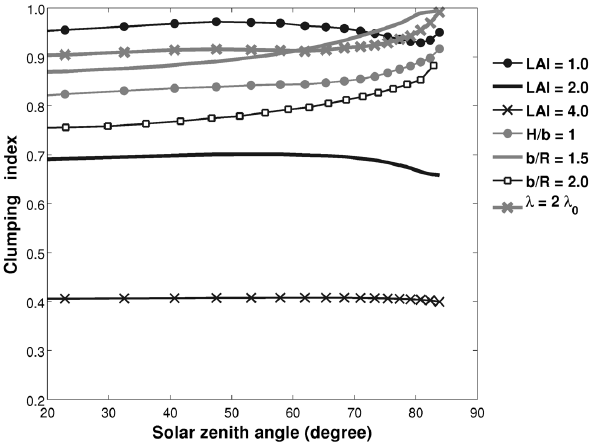
Figure 14. Derived clumping index as a function of solar zenith angle for varied canopy parameters. Tree parameters for US-Bar are used for GORT simulations. The default simulation is for a canopy composed of H/b = 2 . 0, b/R = 3 . 0, λ = 1432treesha − 1 , and LAI = 2 . 0, and labeled curves are for the same case with only the labeled parameters